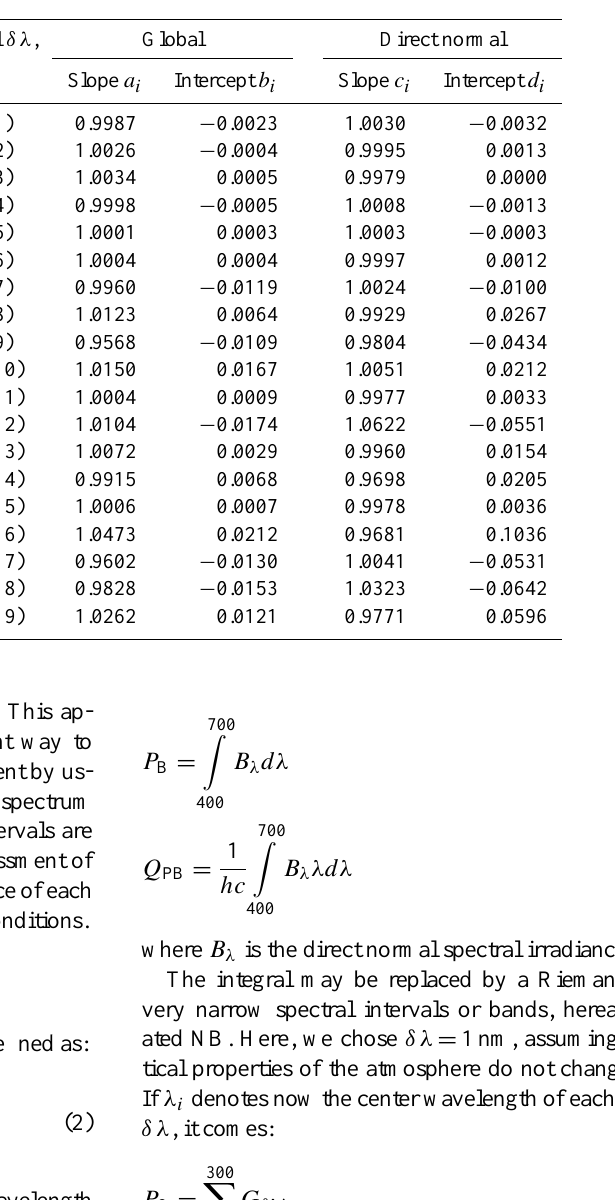
Table 1. KB covering and close to PAR spectral interval, selected sub-intervals δλ i , slopes and intercepts of the affine functions between the clearness indices in KB and sub-intervals δλ i obtained from libRadtran